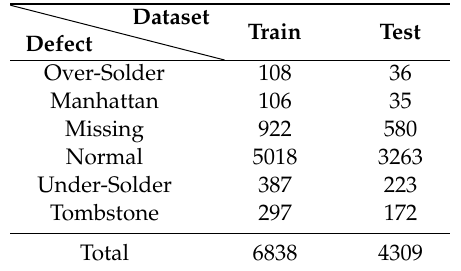
Table 2. SMT defect dataset.